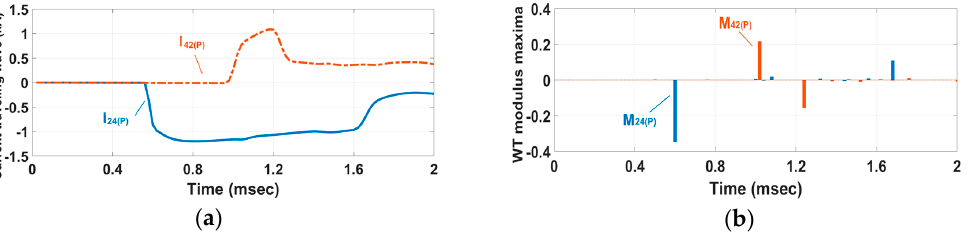
Figure 11. ( a ) Waveforms of current traveling waves at both ends of the positive line in the segment L 24 ; ( b ) Waveforms of their corresponding WT modulus maxima.